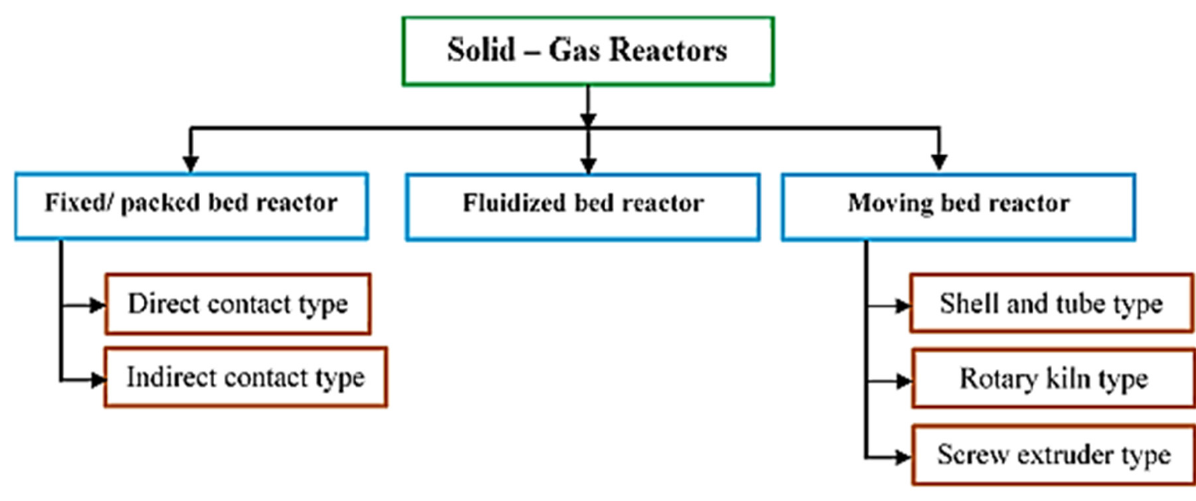
Figure 9. Classification of solid–gas reactors [8].